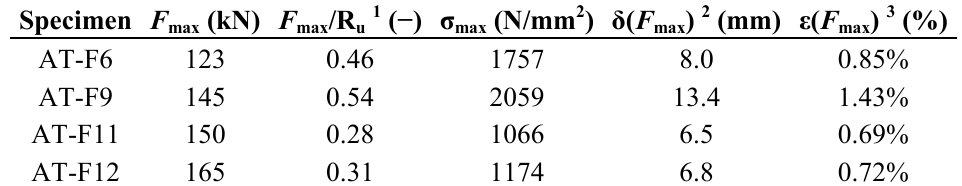
Table 8. Test results of Series